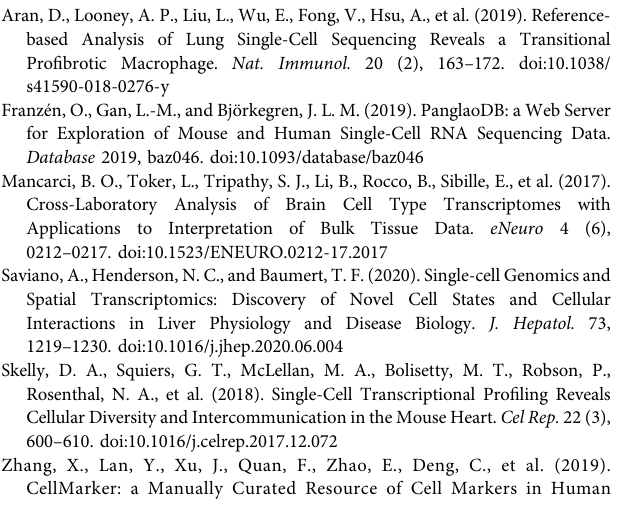
Supplementary Figure 1 | Marker gene score calculation for an individual source/ publication.Foreachmarkergenestatisticinanindividualsource,thestatisticalresults are scaled from 0 (low/no evidence marker gene) to 1 (high evidence marker gene) using the author speci fi ed statistical signi fi cance cutoffs. All gene-celltype pairs in